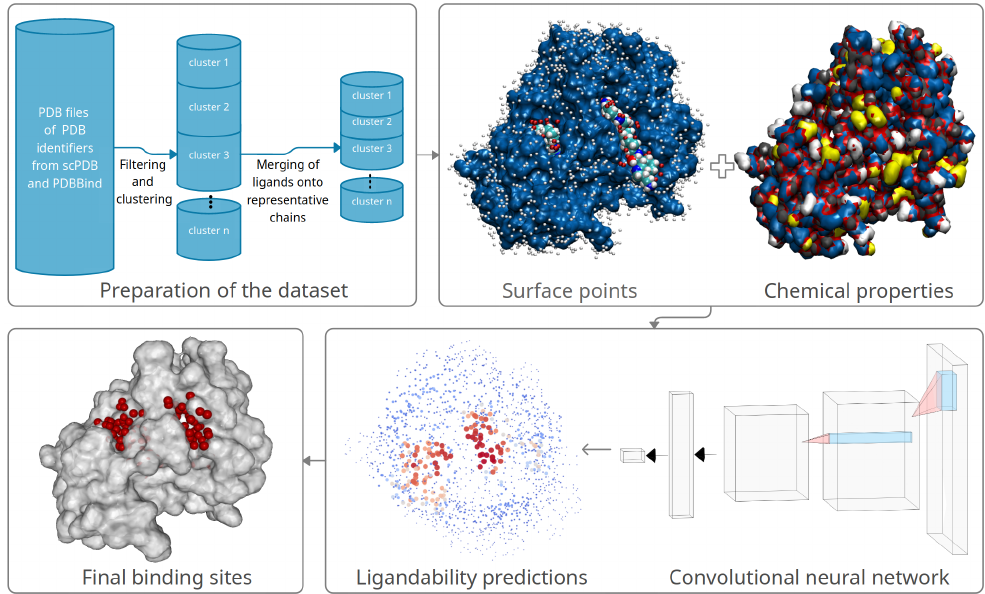
Figure 1. A high-level overview of the proposed method: it consists of preparation of the dataset, followed by surface points and chemical properties computation, training a convolutional neural net- work, predicting ligandability probabilities of surface points, and clustering the predicted ligandable points into predicted binding